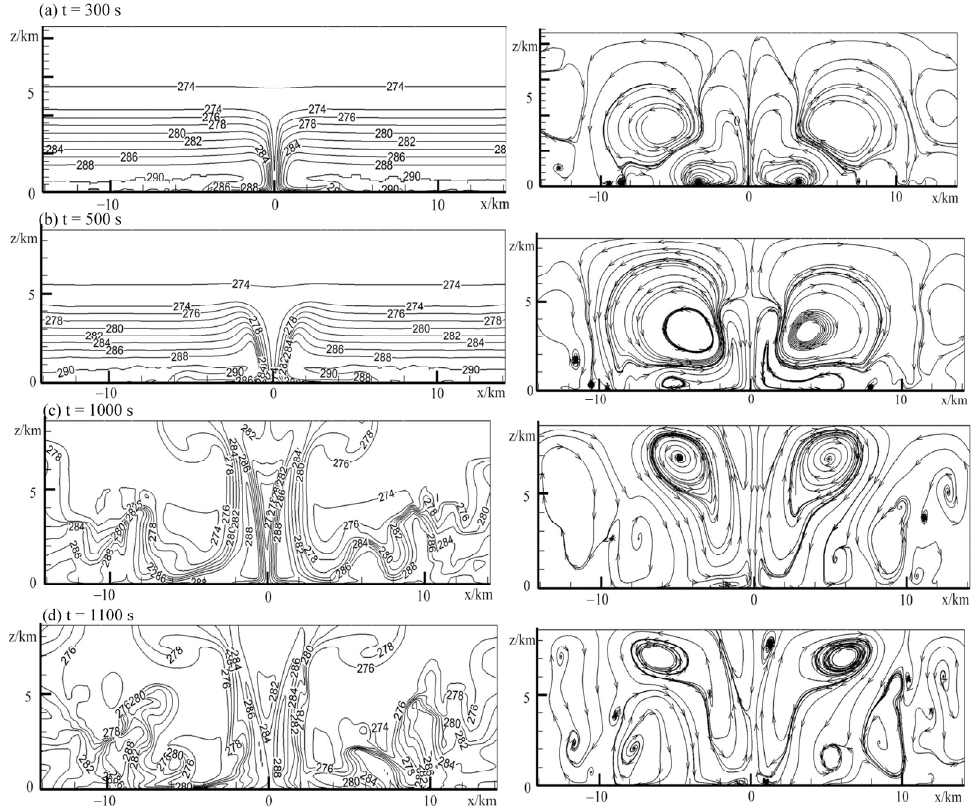
Figure 3. The air temperature and streamlines in the central vertical plane z–x at different times of the initial stage of LSS development. ( a ) t = 300 s; ( b ) t = 500 s; ( c ) t = 1000 s and ( d ) t = 1100 s.